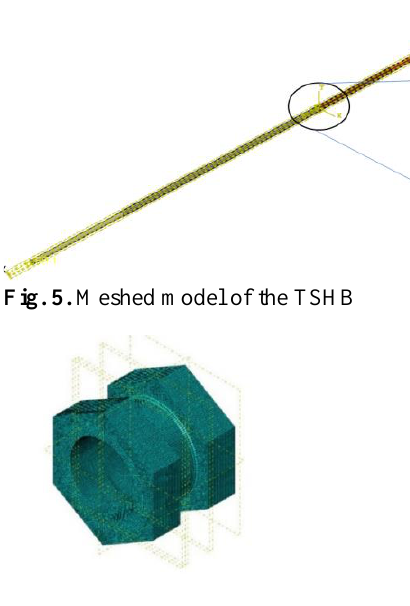
Fig. 6. Meshed Specimen using C3D8R